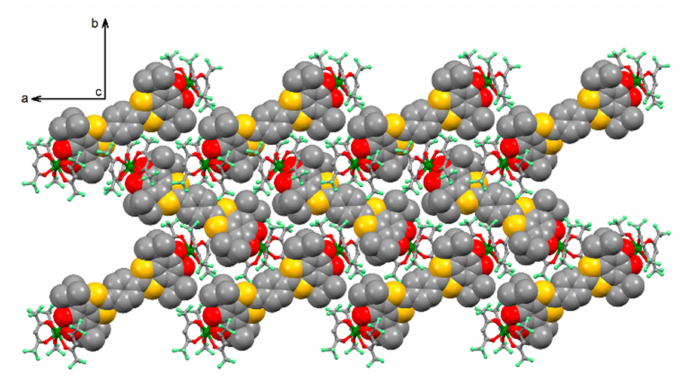
Figure 2. Crystal packing of H 2 SQ-Yb in the (110) plane. “Spacefill” and “ball and sticks” representations are used for H 2 SQ ligands and Yb(hfac) 3 units,